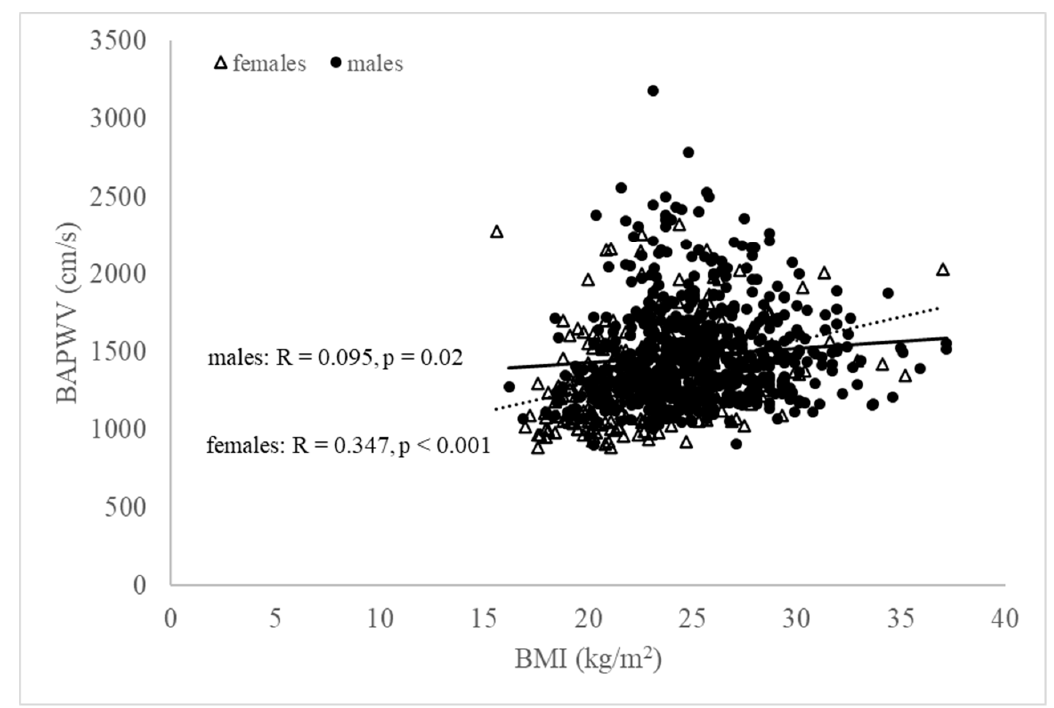
Figure 1. Relationship between BAPWV and BMI (black open triangles, females; black closed circles, males). The correlation between BAPWV and BMI was significantly stronger in females compared to males.